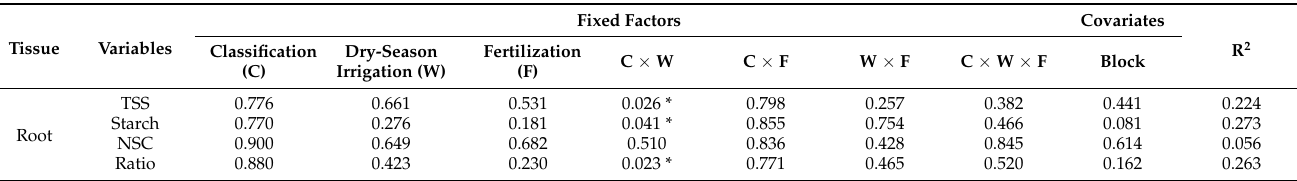
Table 4. The multivariate general linear model (MGLM) of the underground NSC concentrations with treatment, classifica- tion and